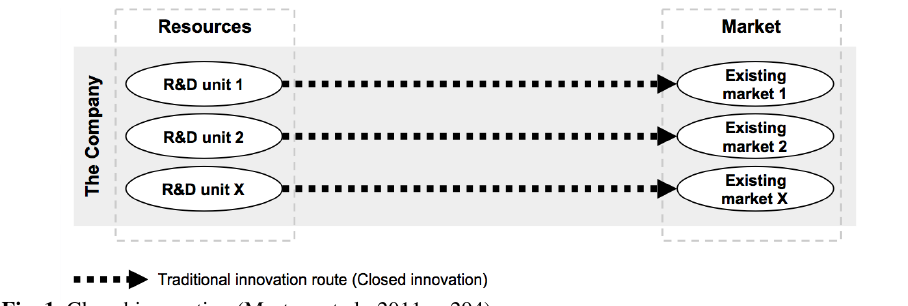
Fig. 1. Closed innovation (Mortara et al., 2011, p 294) In contrast, OI is "the purposive inflows and outflows of knowledge to accelerate internal innovation, and expand the markets for external use of innovation, respectively" (Chesbrough et al., 2006, p.1). This means that with OI, all